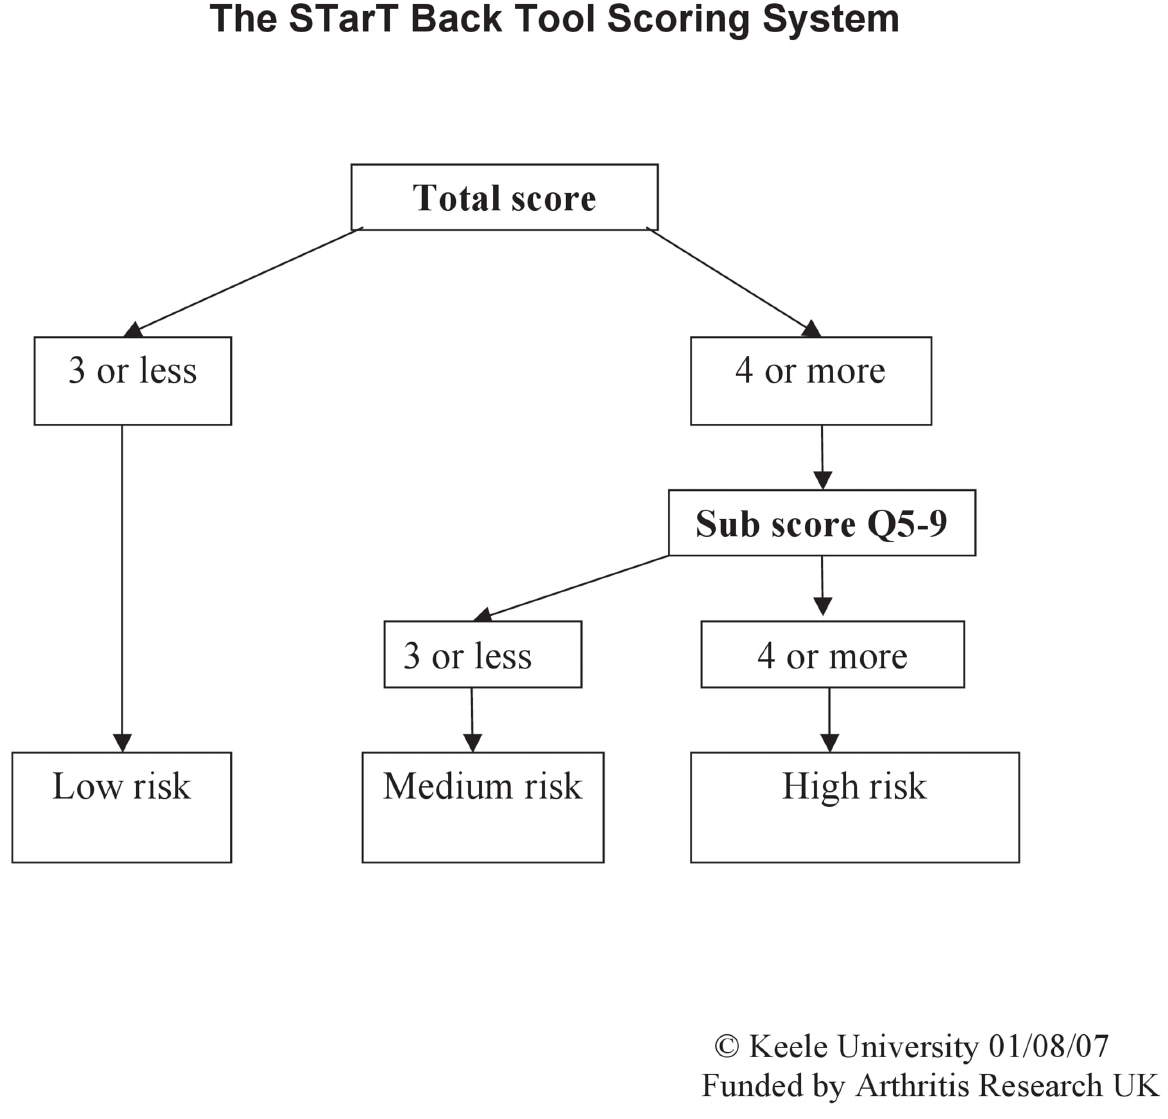
Fig 2. STarT Back Tool risk stratification. Sub score Q5 – 9: psychosocial